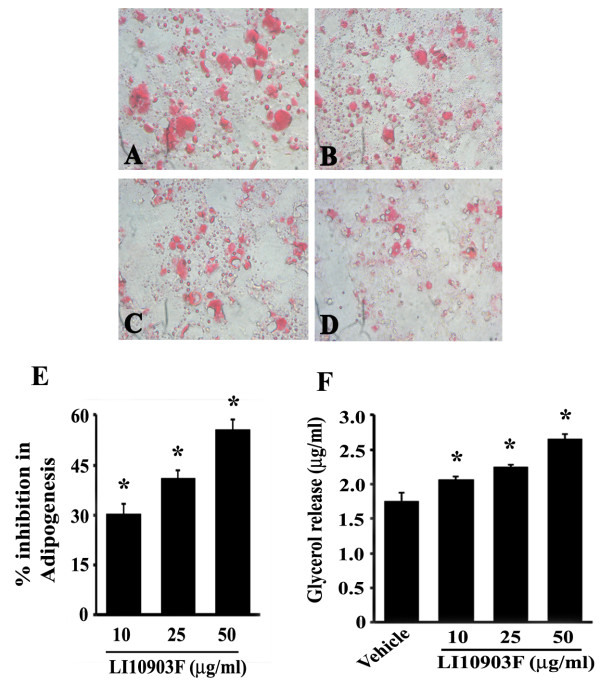
3T3-L1 cells were induced to differentiate in presence or absence of different concentrations of LI10903F. Intracellular Lipids were stained with Oil Red O. Representative photomicrographs show lipid accumulation in the cells treated with 0.1% DMSO as vehicle control (A); cells treated with 10, 25 and 50μg/ml LI10903F (B, C, and D, respectively). Panel E, bar diagram represents percent inhibition of adipogenesis (mean ± SD) in LI10903F treated 3T3-L1 cells relative to the vehicle control cultures (n=3). Bound Oil Red O dye was eluted from treated adipocytes with 100% isopropyl alcohol, and the OD was read at 550 nm. * Denotes significantly different compared to control cultures, p<0.05. Panel F, 3T3-L1 adipocytes were treated with either different concentrations of the herbal blend (10, 25 or 50μg/mL) or 0.1% DMSO (control). Lipid breakdown was estimated based on the amount of glycerol released in the culture medium. Bar diagram represents released glycerol (mean ± SD) in LI10903F treated and vehicle treated cultures (n=3). *Denotes significantly different compared to vehicle treated controls, p<0.05.